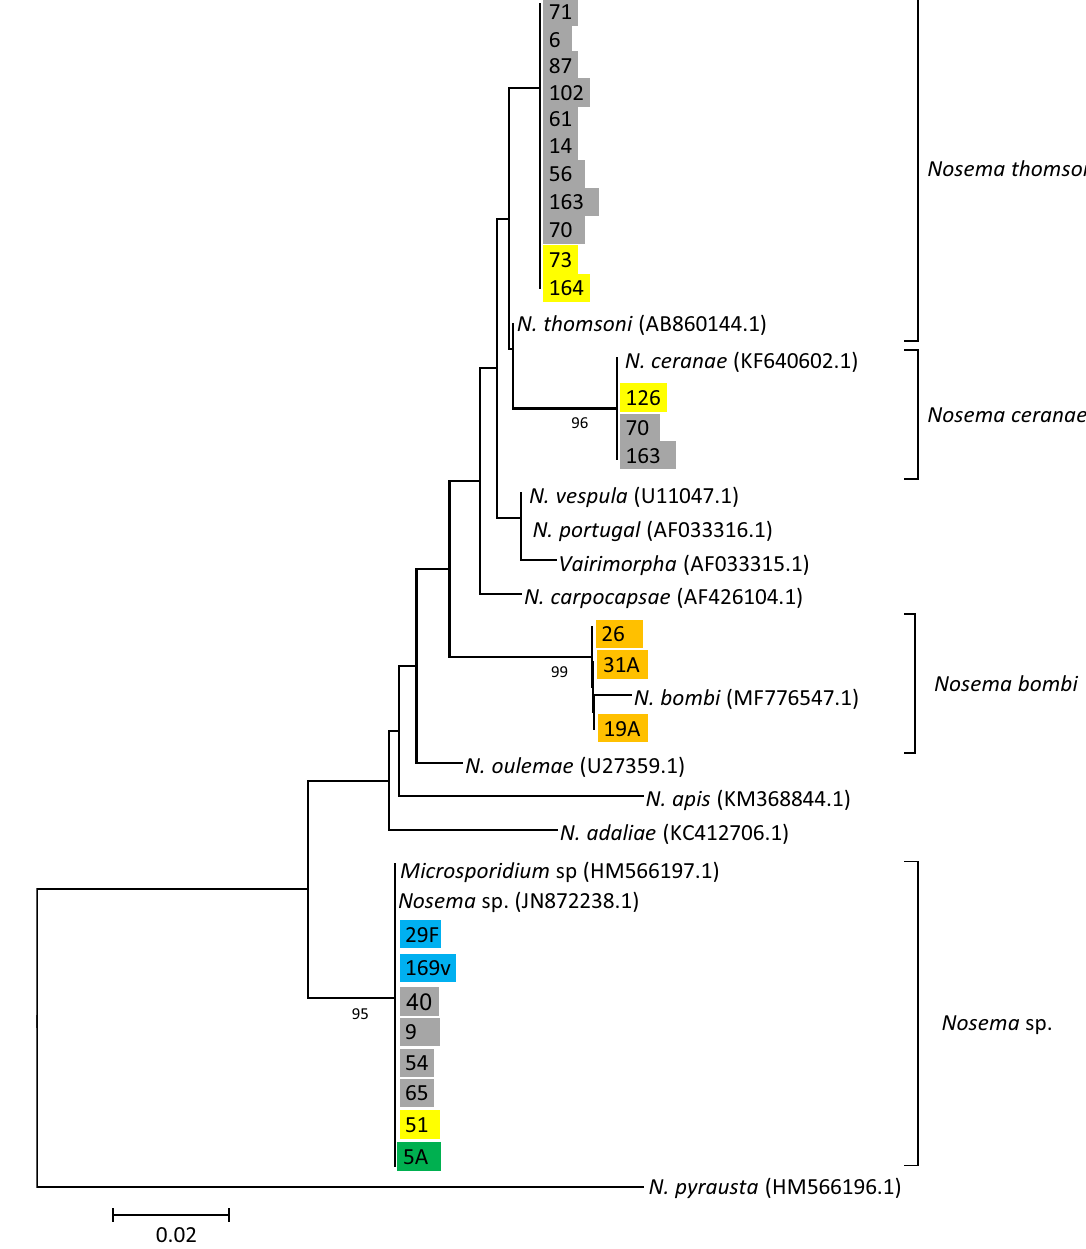
Figure 1. Phylogenetic relationships of the SSU-rRNA sequences from Nosematidae. Sequence names indicate the sample name and are color-coded by host groups: V. velutina (grey), V. crabro (yellow), Bombus spp. (orange), Vespula spp. (blue), Polistes spp. (green). Some sequences that were slightly shorter or with double peaks were excluded. The evolutionary history was inferred using the NJ method. Bootstrap values higher than 70% are shown next to branches. The evolutionary distances were computed using the Tamura 3-parameter method and are in the units of the number of base substitutions per